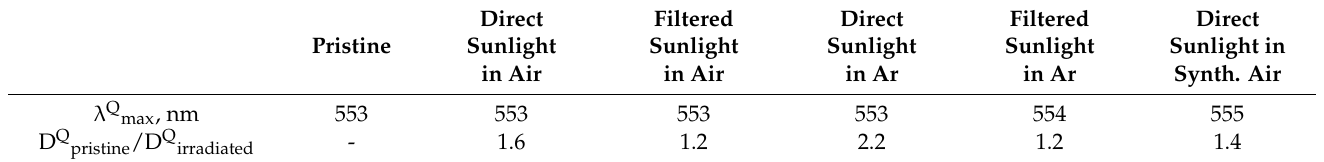
Table 2. Maximum of Q-band ( λ Q max ) and ratio of the optical density at λ Q max in pristine